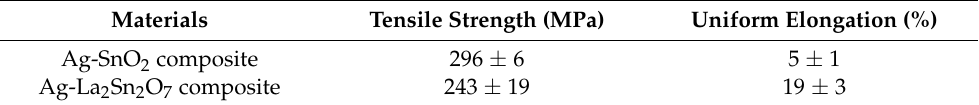
Figure 3. Engineering stress–strain curves ( a ); fracture morphologies of pure Ag ( b ), Ag-SnO 2 composite ( c ) and Ag-La 2 Sn 2 O 7 composite ( d ). Table 1. Mechanical properties of the Ag − SnO 2 composite and Ag − La 2 Sn 2 O 7 composite.